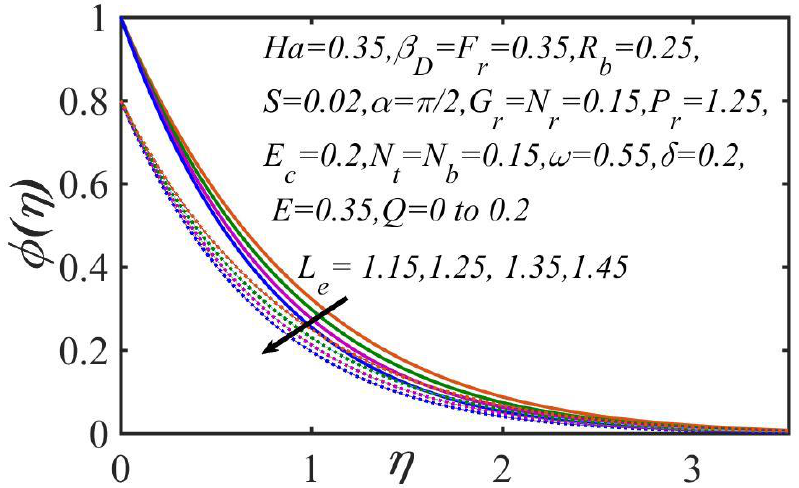
Figure 11. Influence of 𝐿 𝑒 and “ 𝑄 ” on the concentration magnitudes. Solid curve: 𝑄 = 0 ; dotted curve: 𝑄 = 0.2 .